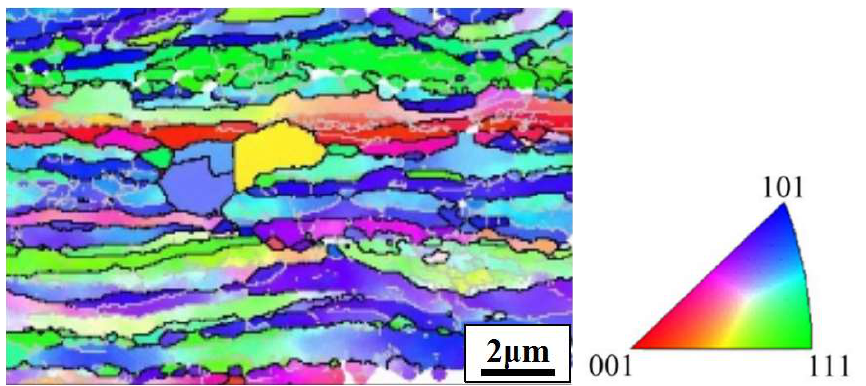
Figure 2. IPF diagram of EBSD orientation image of the longitudinal section of copper foil.